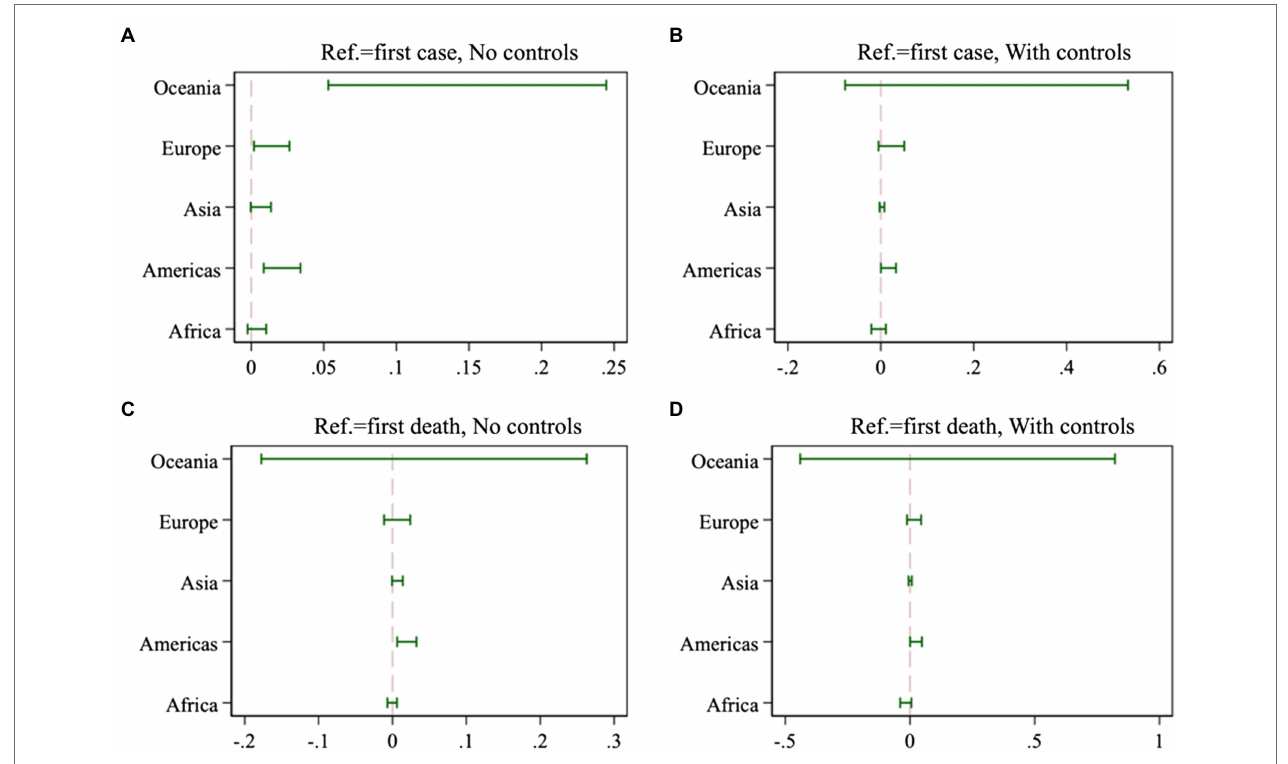
FIGURE 5 | Coefficients of Post * LC from continent-specific